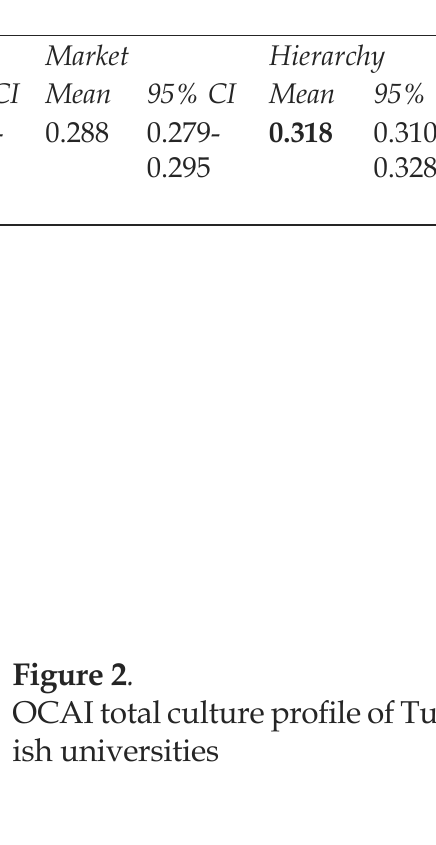
Figure 2 . OCAI total culture pro (cid:192) le of Turk- ish